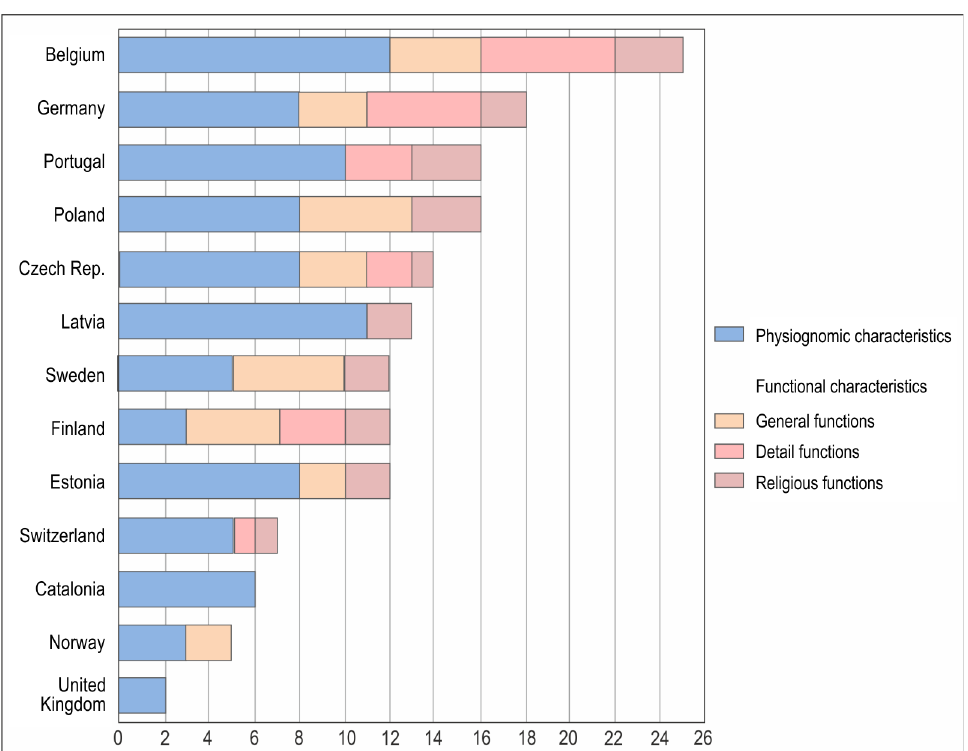
Fig. 1. The number of characteristics of buildings, structures and build-up areas on 1:10,000 maps, divided into different